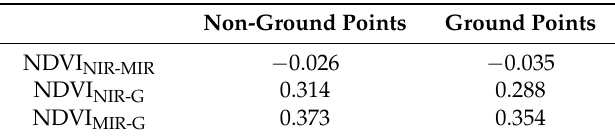
Table 5. Threshold values ( NDVI_thrd